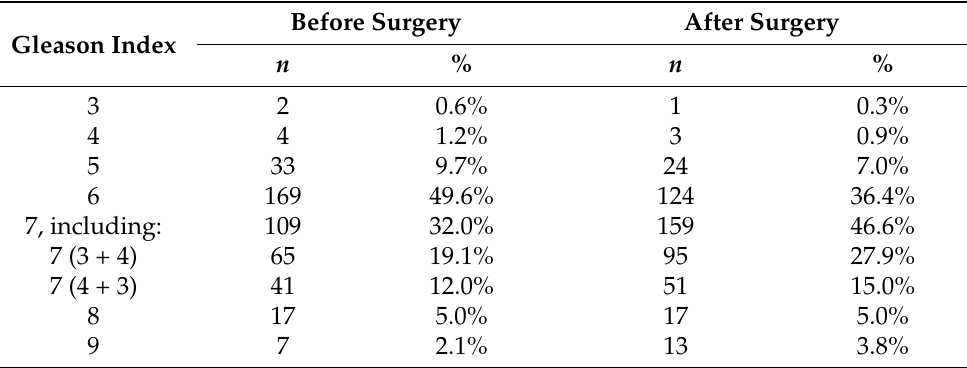
Table 2. Distribution of patients by the degree of tumor malignancy according to the Gleason scale in accordance with the final histological conclusion.